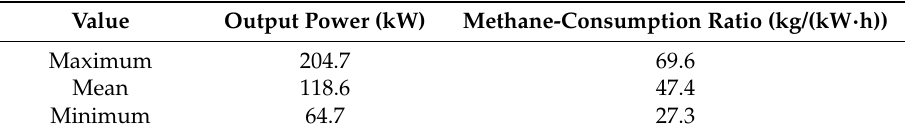
Table 2. Predicted results